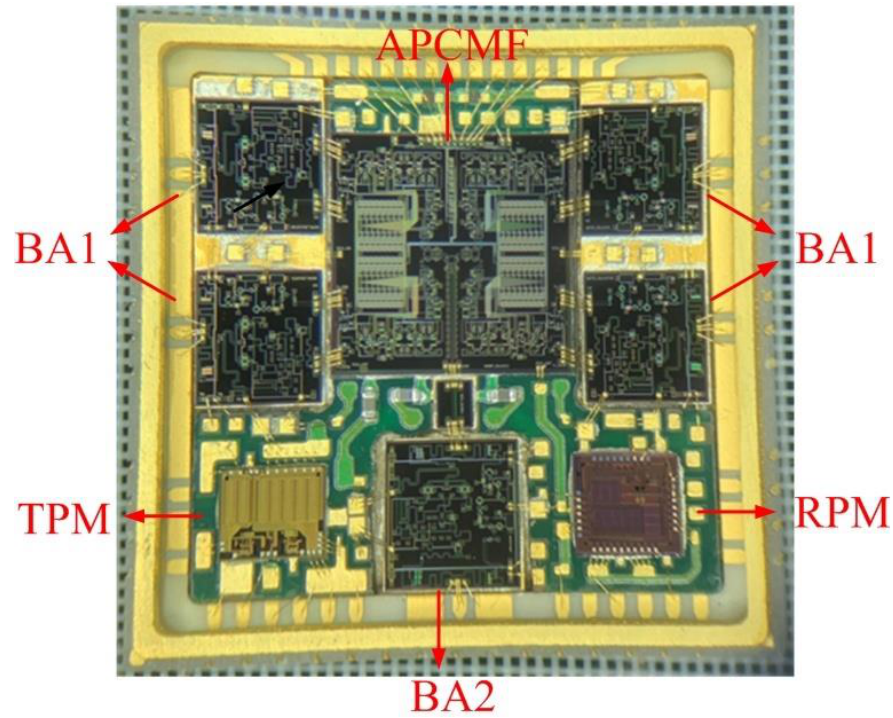
Figure 7. Internal photograph of the proposed transceiver SIP.